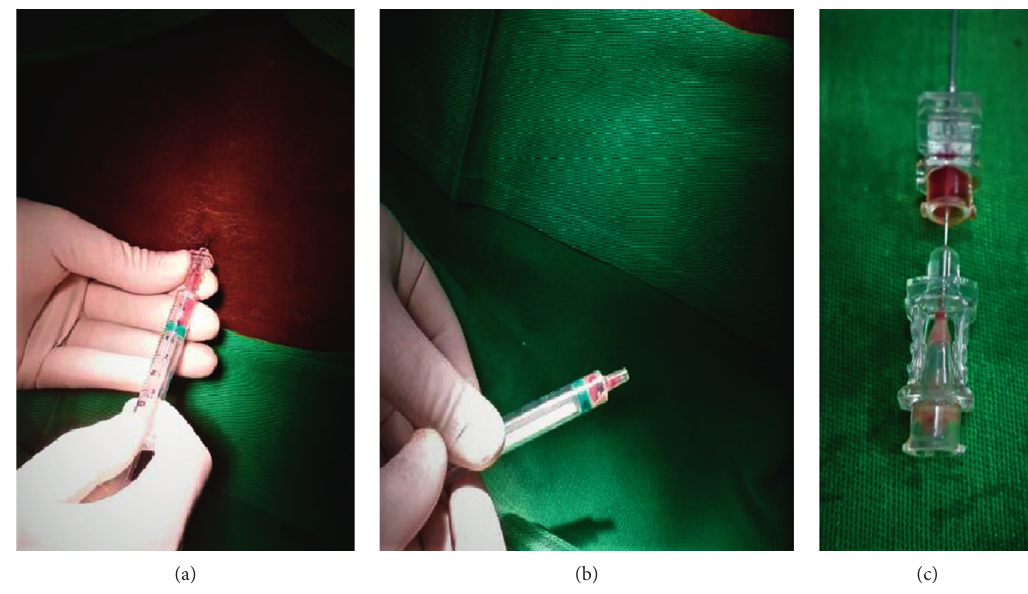
Figure 1: (a)–(c) Pus noted during subarachnoid